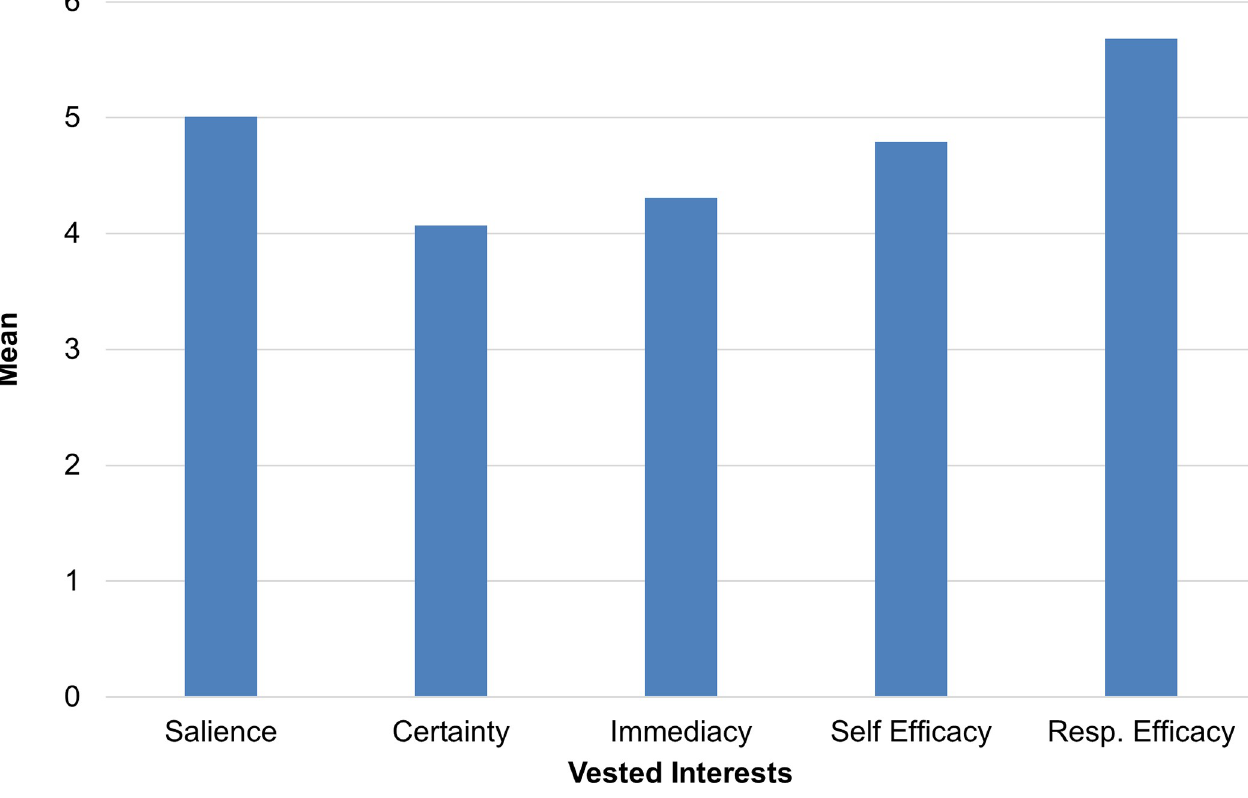
Fig 1. Means of vested interests variables for all